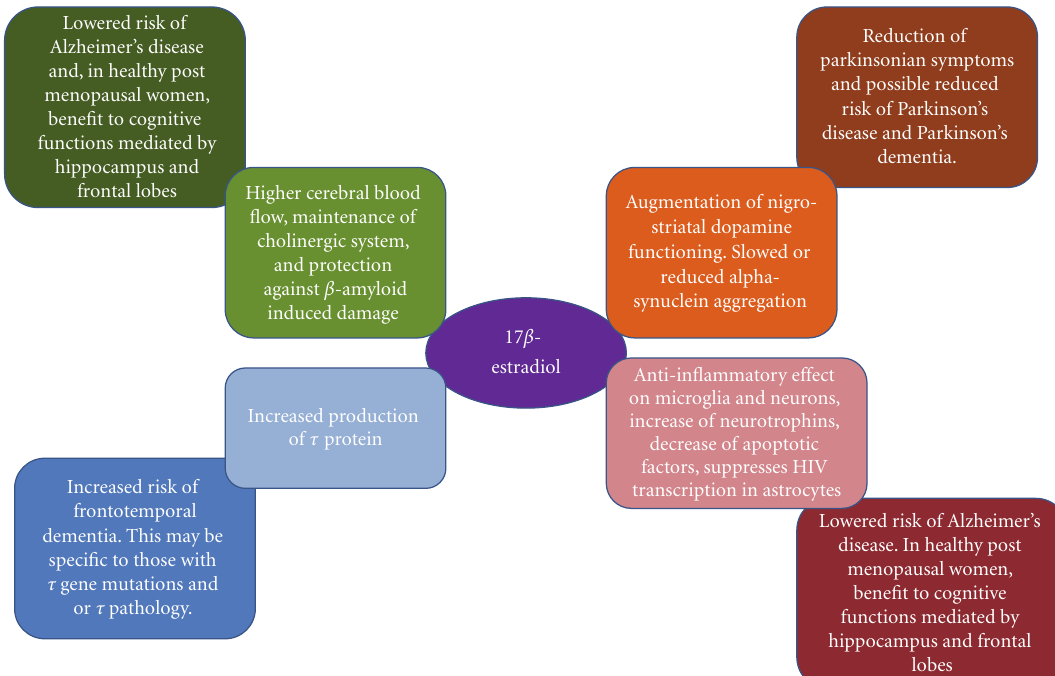
Figure 1: Putative mechanisms through which 17 β -estradiol exerts neuroprotective and neuro-adverse e ff ects. In the context of Alzheimer’s disease, Parkinson’s disease, and HIV, 17 β -estradiol appears to be neuroprotective. However, frontotemporal dementia is often the result of mutated tau protein and/or tau-related pathology. Because 17 β -estradiol increases production of tau, it may accelerate risk for some forms of frontotemporal